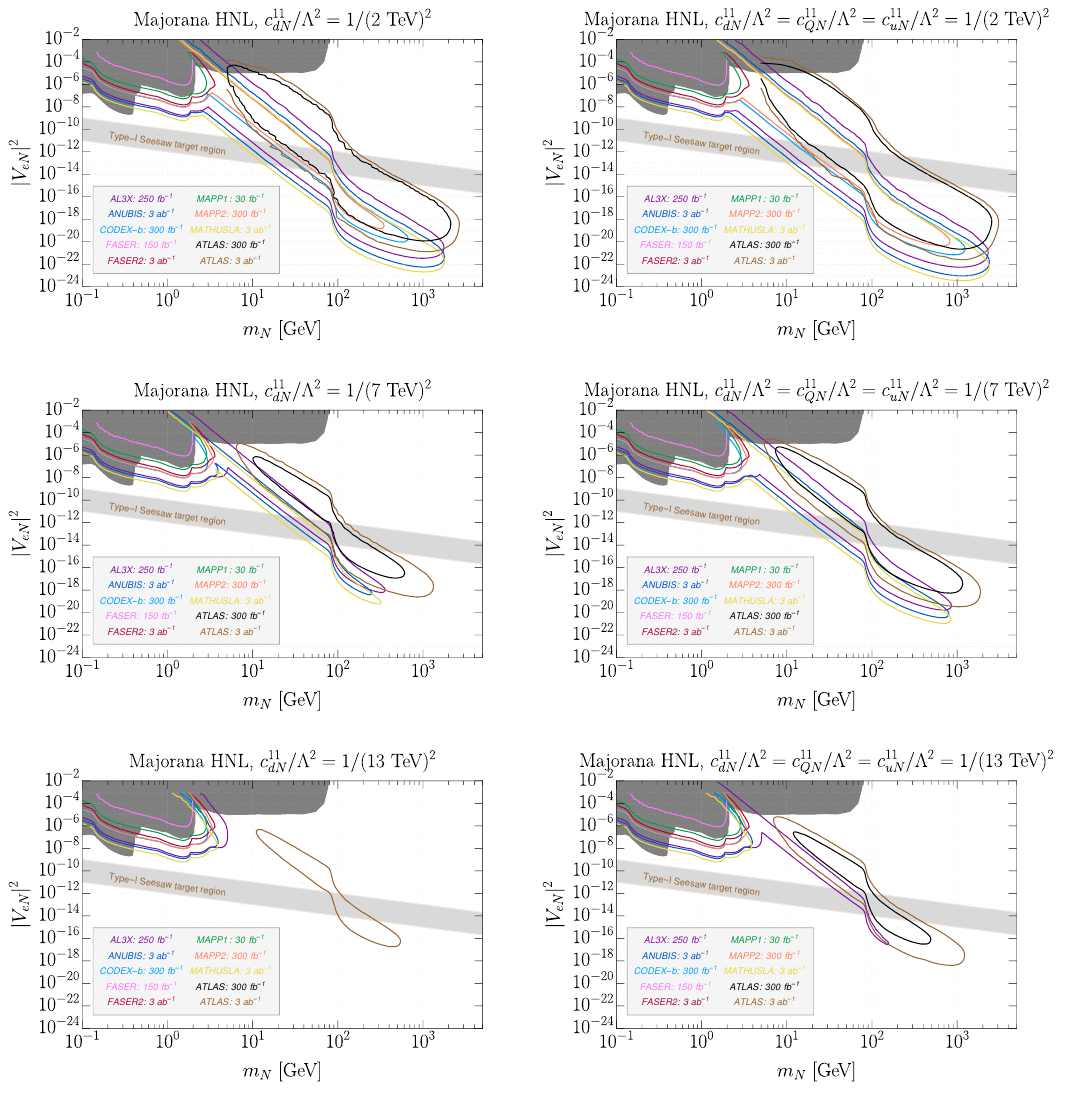
Figure 5 . Experimental sensitivity reach on | V eN | 2 as a function of m N for Majorana HNLs. The left panel contains results for one single operator O dN only. The plots on the right are for the case where all the three types of effective operators are switched on simultaneously. The values of the respective operator coefficients are fixed to c O / Λ 2 = 1 / (2 TeV ) 2 , 1 / (7 TeV ) 2 and 1 / (13 TeV ) 2 . The dark gray region has been excluded by various experiments including searches from CHARM [23], PS191 [24], JINR [25], and DELPHI [26], and the light gray band corresponds to the parameter space with the type-I seesaw relation assumed for active neutrino masses between 10 − 3 and 10 − 1